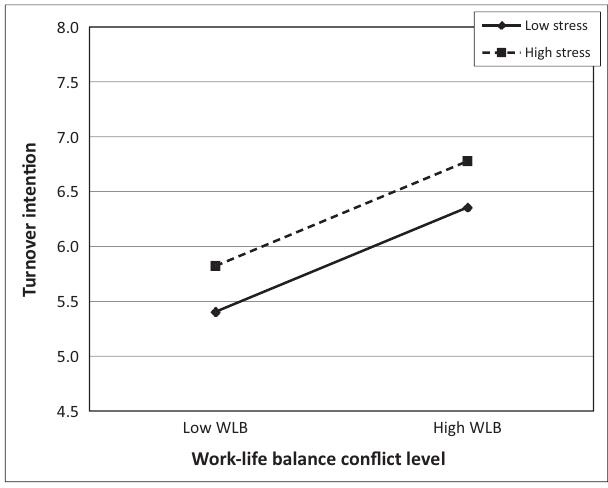
Work-life balance conflict FIGURE 6: Stress as a moderator on the work-life balance–turnover intention relationship (two-way interaction).